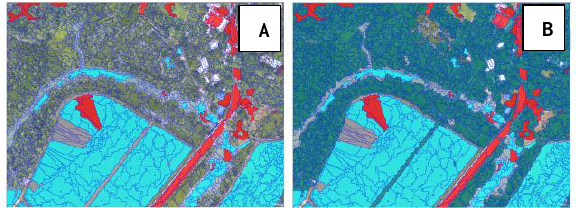
Figure 5. Segments before (A) and after (B) Vegetation classification using assign class algorithm with mean CHM minimum threshold value of